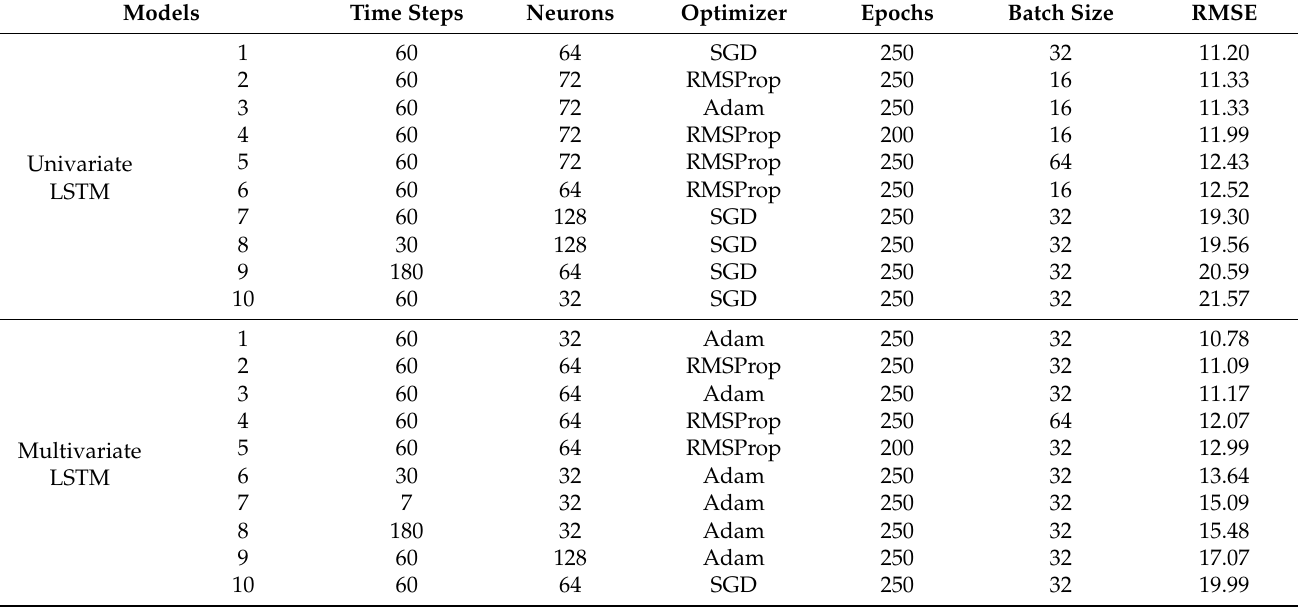
Table 4. Comparison of the univariate LSTM and multivariate LSTM models.